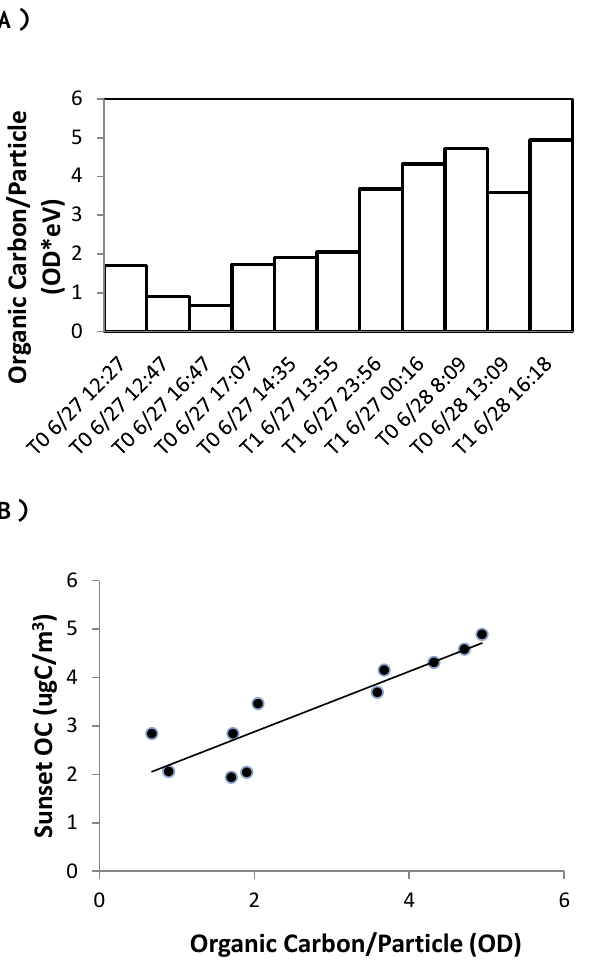
Fig. 10. (A) Trend in average total organic carbon per particle deter- mined by integrating the ionization edge step. (B) Relationship be- tween organic carbon optical density per particle and bulk organic Figure 10. A) Trend in average total organic carbon per particle determined by integrating the 6 mass concentration measured by Sunset OCEC analyzer. ionization edge step. B) Relationship between organic carbon optical density per particle and 7